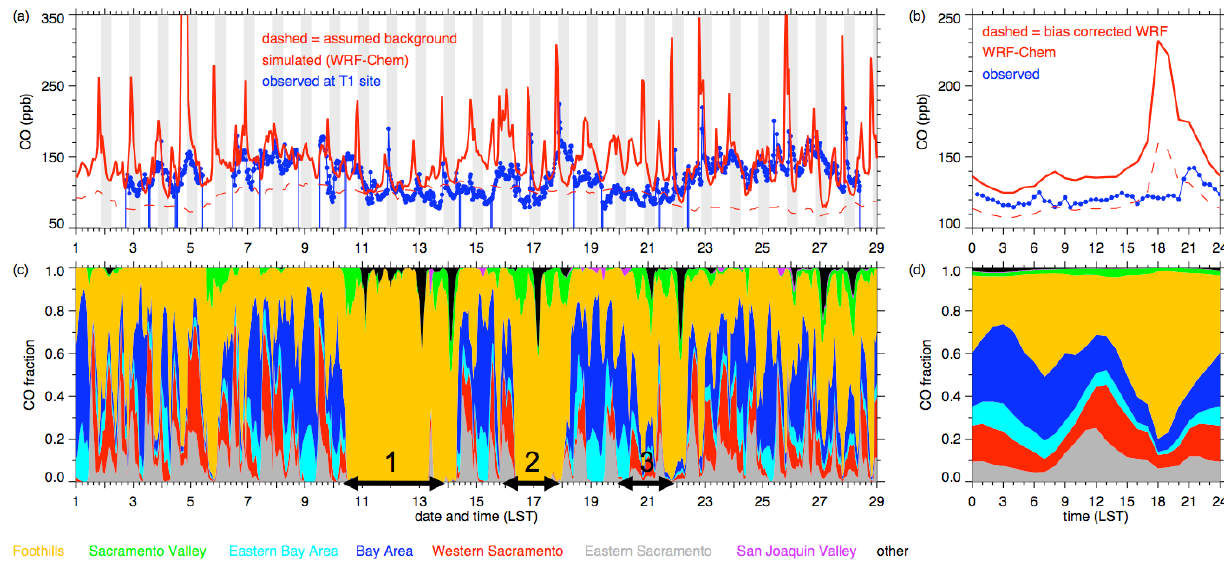
Figure 15. Same as Figure 14, except at the T1 site northeast of Sacramento. 1022 Fig. 15. Same as Fig. 14, except at the T1 site northeast of